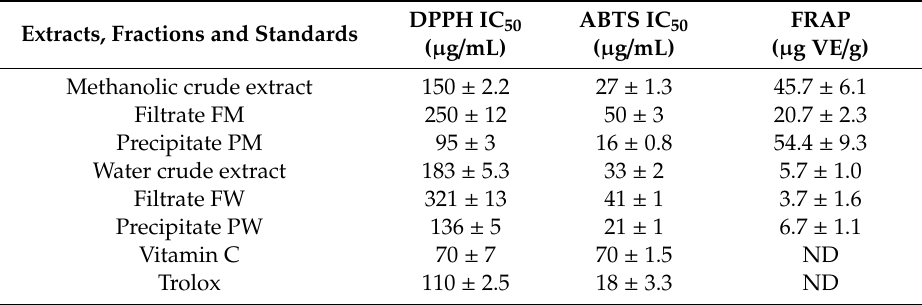
Table 2. Antioxidant activity of bark extracts of A. seyal